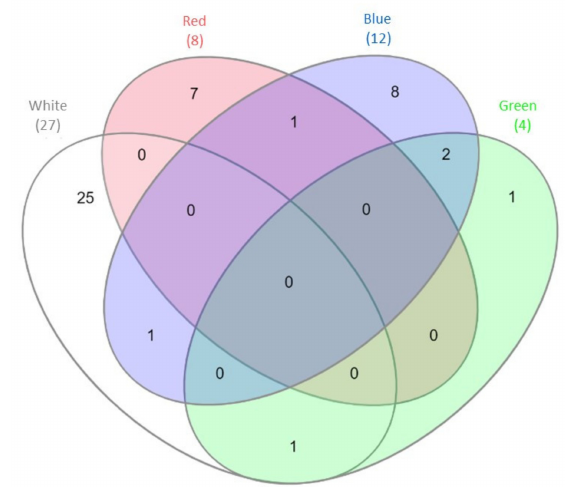
Figure 1. Venn diagram [29] demonstrating the number of di ff erentially expressed genes (DEGs) engaged in proteolytic processes detected during C. unicolor growth in white light (light grey), green light (green), red light (red), blue light (blue) vs. dark conditions. The numbers of DEGs common / unique for the white, red, blue and green vs. dark conditions are